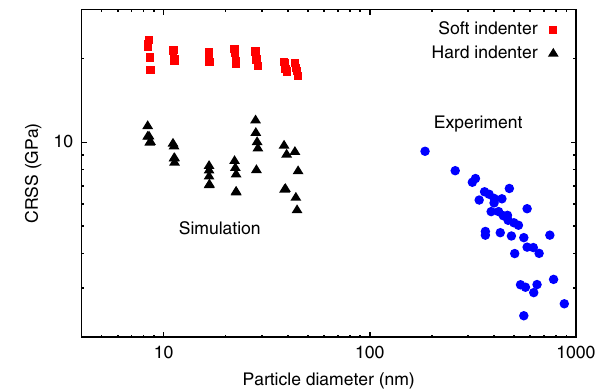
Fig. 6 Comparison of simulated and experimental compressive strengths of Ni nanoparticles. The CRSS is plotted as a function of the particle diameter. The simulations were performed on particles with shapes similar to those in the experiments (roundness parameter 0.025< Γ < 0.035) using